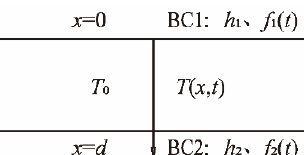
Figure 7. One-dimensional model of the temperature distribution.